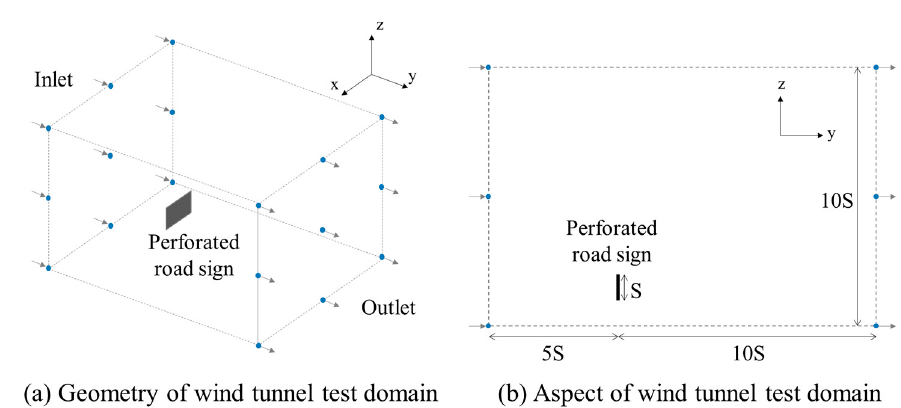
Figure 2. Virtual wind tunnel domain.